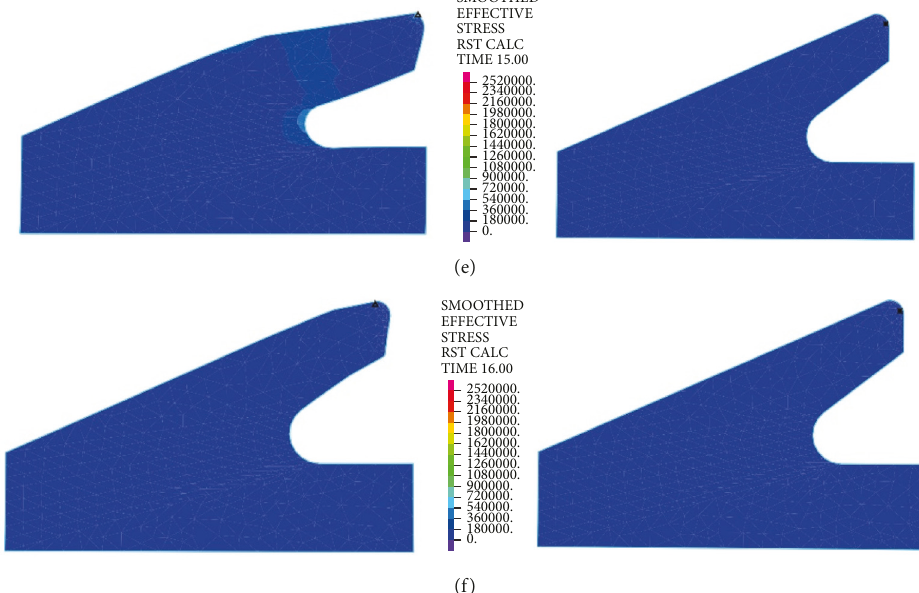
Figure 12: Effective stress distribution of the rubber rings after optimizing during clockwise rotation. (a) Deflection 0.2 ° . (b) Deflection 0.4 ° . (c) Deflection 0.6 ° . (d) Deflection 0.8 ° . (e) Deflection 1.0 ° . (f) Deflection 1.2 °